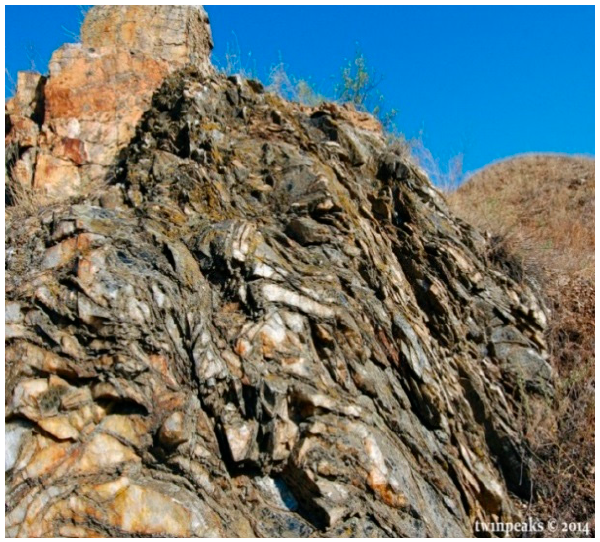
Figure 2. Manifestations of phlogopite clusters.